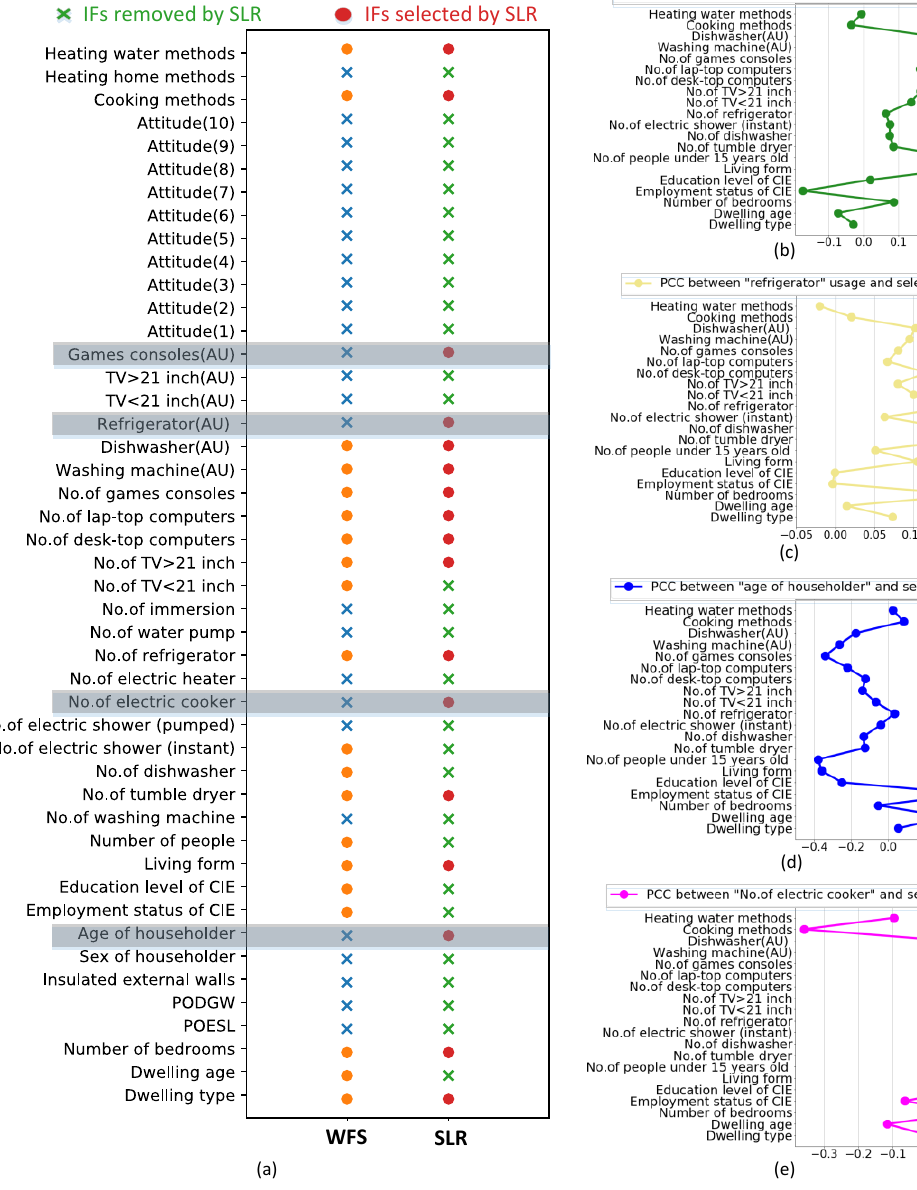
Figure 9. The feature selection results of WFS and SLR, the PCCs between redundant IFs (i.e., “game console” usage, “refrigerator” usage, “age of householder” and “No. of electric cooker”) and selected IFs (listed in the left part of each figure) is shown in the above figures. For example, in Figure (b), each point corresponds to a certain value of the abscissa and this value represents MIC (ranges from 0 to 1) between “refrigerator” usage and the IF to which that point corresponds in the left part of this figure. ( a ) the feature selection results of WFS and SLR; ( b ) MICs between “game console” usage and selected IFs; ( c ) MICs between “refrigerator” usage and selected IFs; ( d ) MICs between “age of householder” and selected IFs; ( e ) MICs between “No. of electric cooker” and selected IFs.